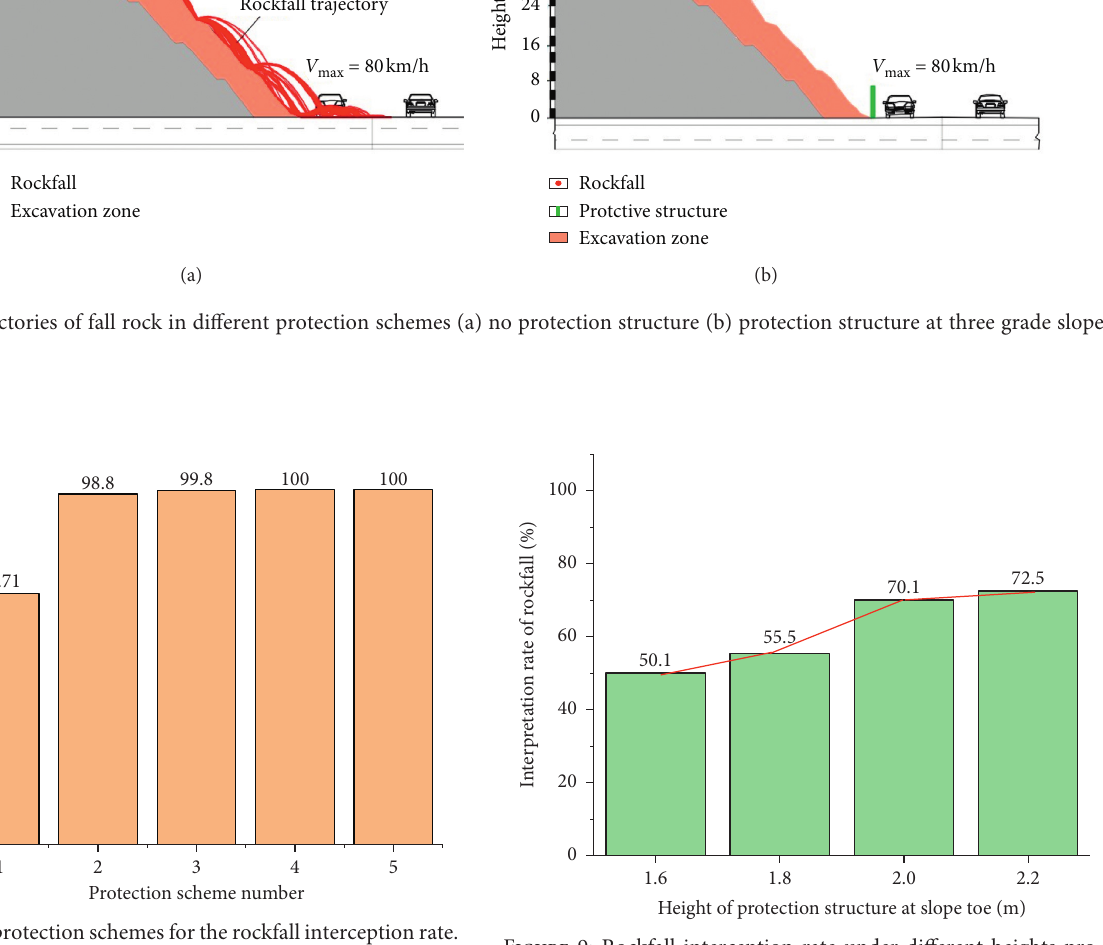
Figure 9: Rockfall interception rate under different heights pro- tection structure at slope